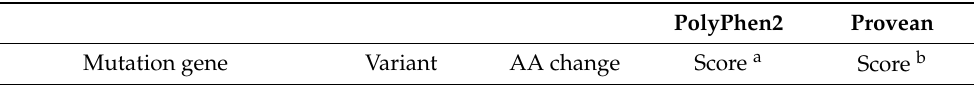
Table 1. Prediction of protein function. a A larger score (close to 1) of PolyPhen2 revealed a probably